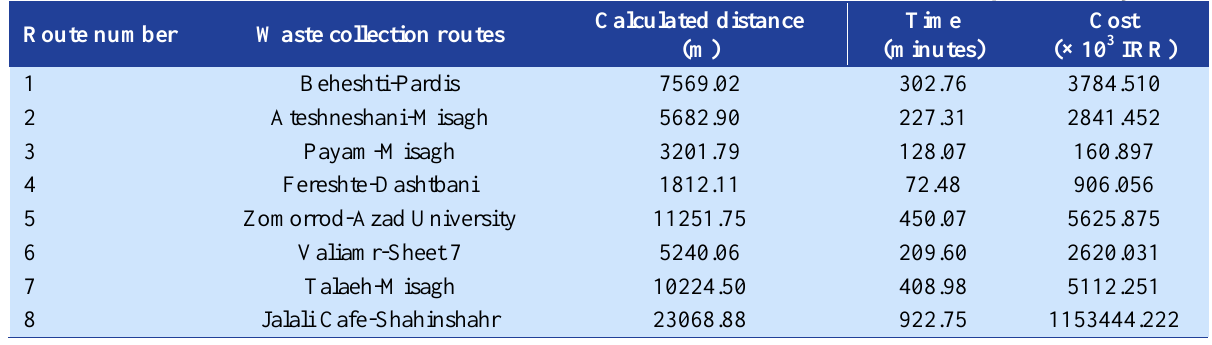
Table 4. Calculated distance, travel time, and the cost of waste collection and transportation system Route